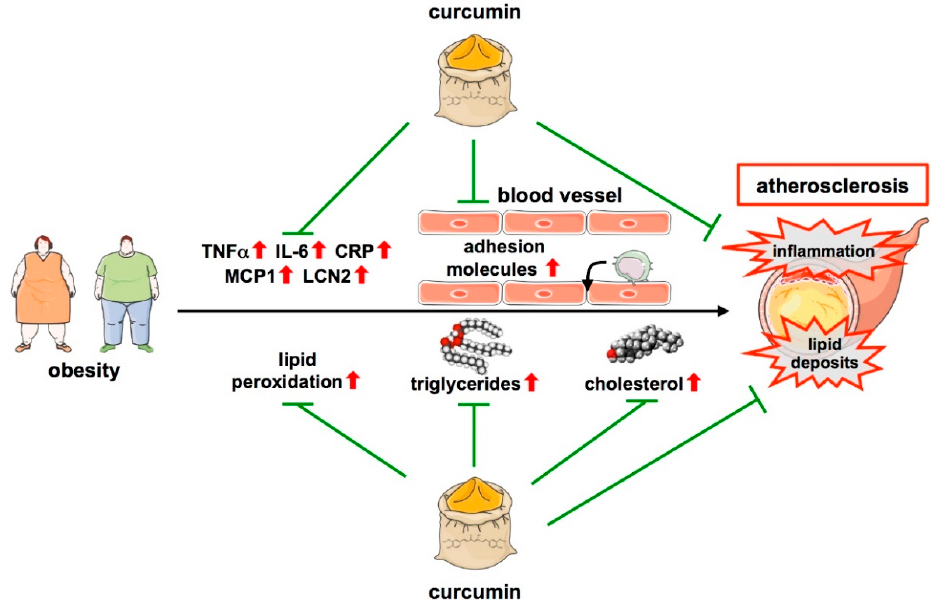
Figure 3. Protective functions of curcumin in atherosclerosis. Obesity is one major risk factor for atherosclerosis development. Atherosclerosis is characterized by low-grade inflammation with an increase in cytokines such as TNF α , IL-6, CRP, MCP1, and LCN2. Moreover, monocytes can infiltrate the vascular wall, another critical step in atherosclerosis development. By downregulating cytokines and reducing macrophage adhesion to the endothelium, curcumin attenuates inflammation. Another feature of atherosclerosis is lipid deposition in areas where atherosclerotic plaques develop, even long before an overt disease. This is fostered by lipid peroxidation as well as increases in serum triglycerides and cholesterol, all of which are attenuated by curcumin, which also leads to a favorable, non-atherogenic lipid profile reducing lipid deposition. ↑ —increased; ↓